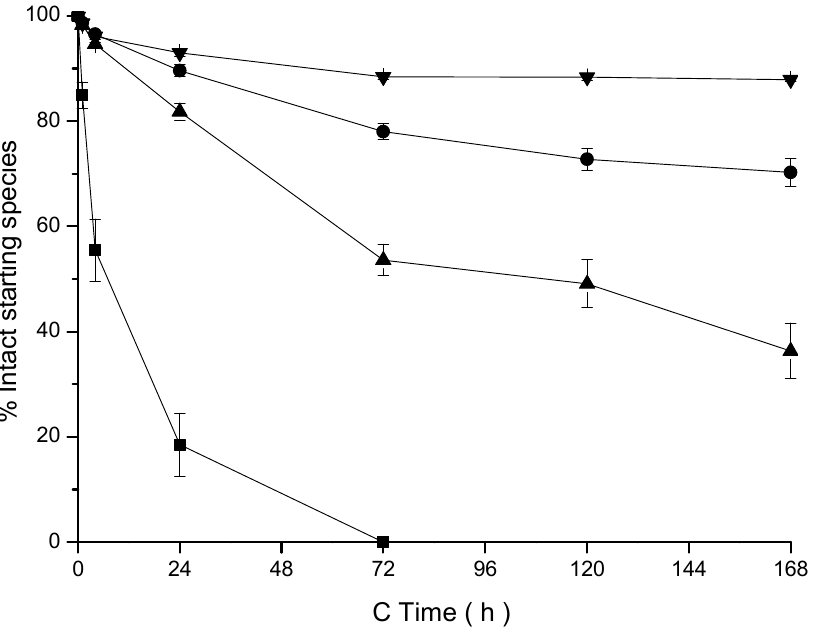
Figure 3. Acid dissociation studies of [ 89 Zr]Zr-DFO ( ─ ⬛ ─ ), [ 89 Zr]Zr-TAFC ( ─ ● ─ ), [ 89 Zr]Zr-FSC(succ) 2 AA ( ─▲─ ) and [ 89 Zr]Zr-FSC(succ) 3 ( ─▼─ ) in a 1000-fold molar excess of EDTA solution at pH 7 ( A ), pH 6 ( B ), and pH 4 ( C ).